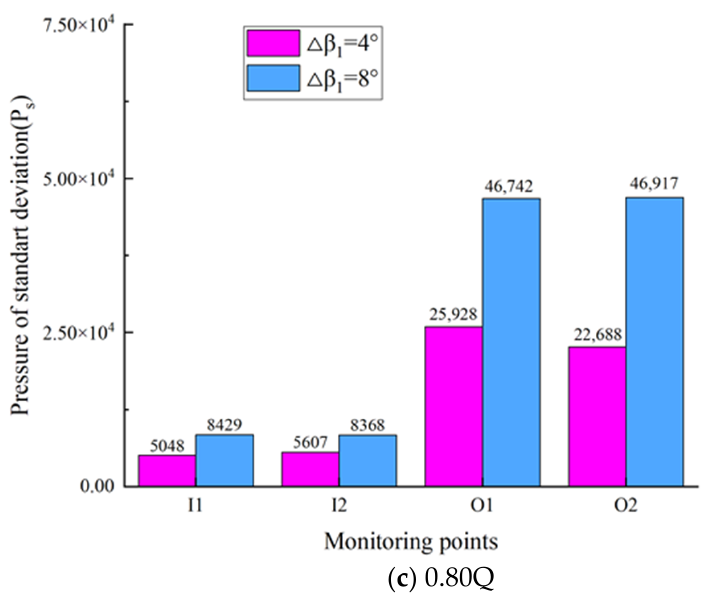
Figure 13. Pressure of standard deviation for monitoring points under flowrate conditions.